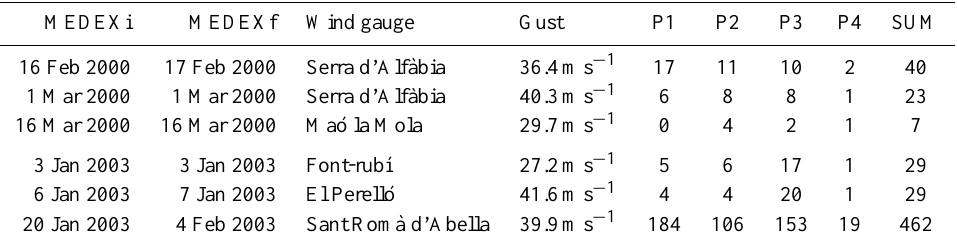
Table 2. Example of the SIR database for SW events. See text for